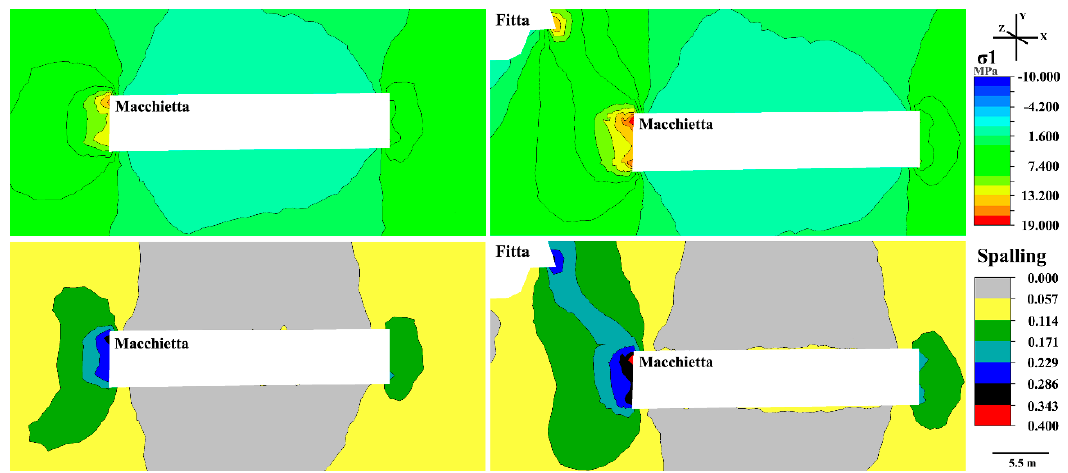
Figure 9. Zones of influence between contiguous openings (S-N look direction); major principal field stress ( top ) and spalling ratio values ( bottom ) considering isotropic elastic material and including the Fitta quarry ( right ) or not ( left ).